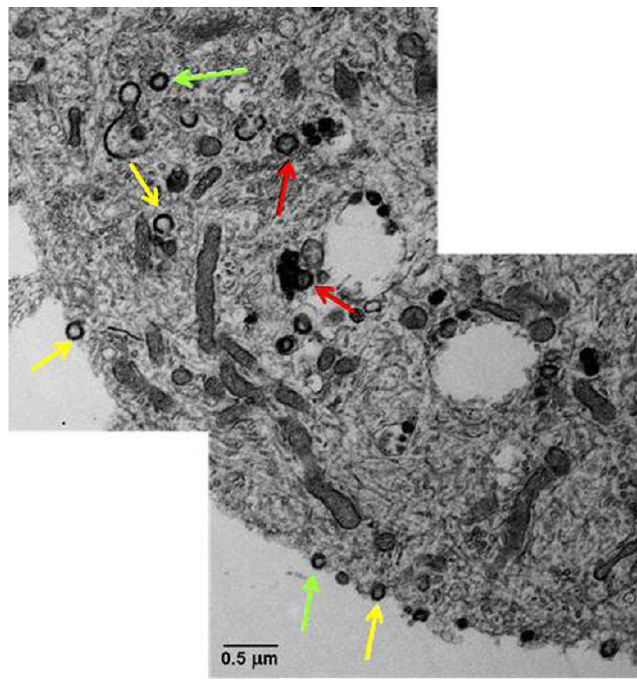
Figure 2. Transmission electron microscopy of VZV-infected human neurons derived from induced pluripotent stem cells. A montage of the cytoplasm and cell surface of a VZV-infected neuron showed viral particles without capsids and viral DNA (yellow arrows), viral particles with capsids but not viral DNA (green arrows), and complete viral particles with capsid and DNA (red arrows). Copied and modified with permission from J. Virol [34].